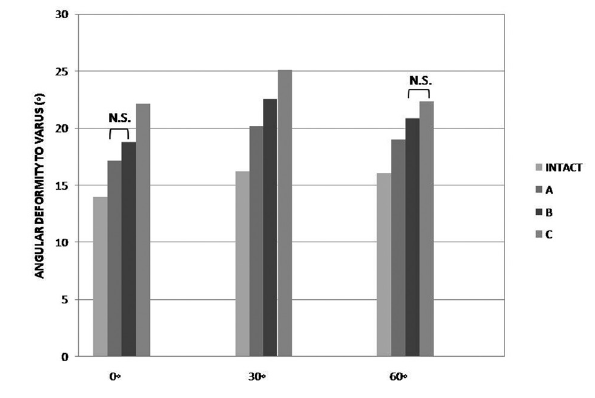
Figure 4 - Comparison of angular deformity to varus among groups with 0, 30 and 60 degrees of flexion. All values were significant, except where notated N.S. (not significant).